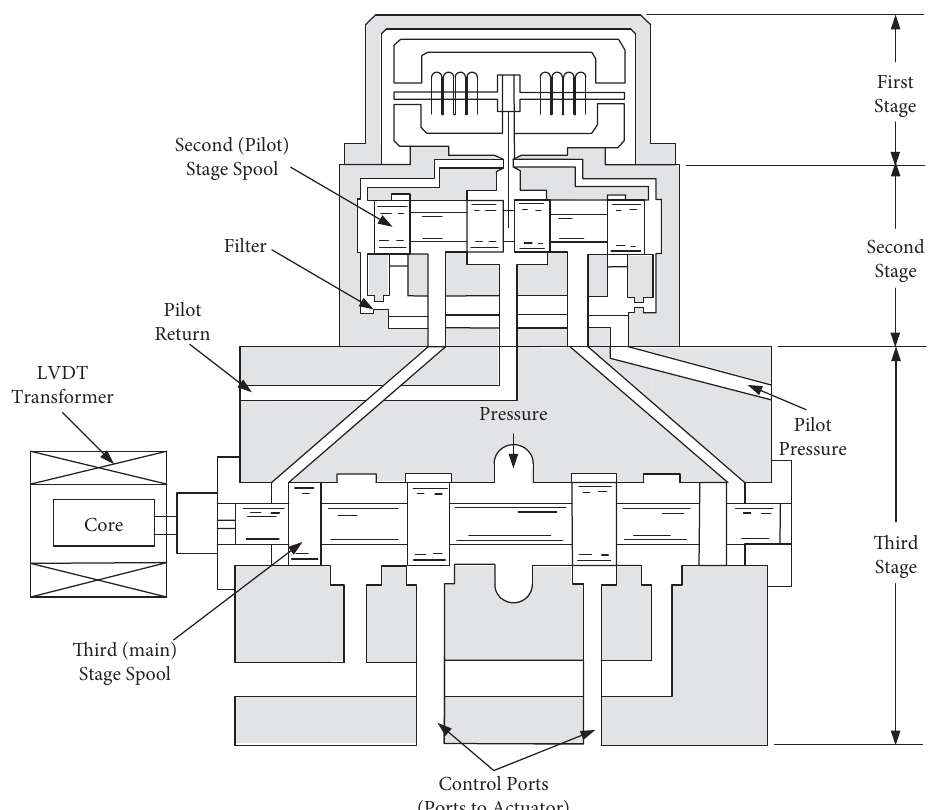
Figure 1: Working principle of the actuator. Note: LVDT transformer is short for the linear variable differential transformer.